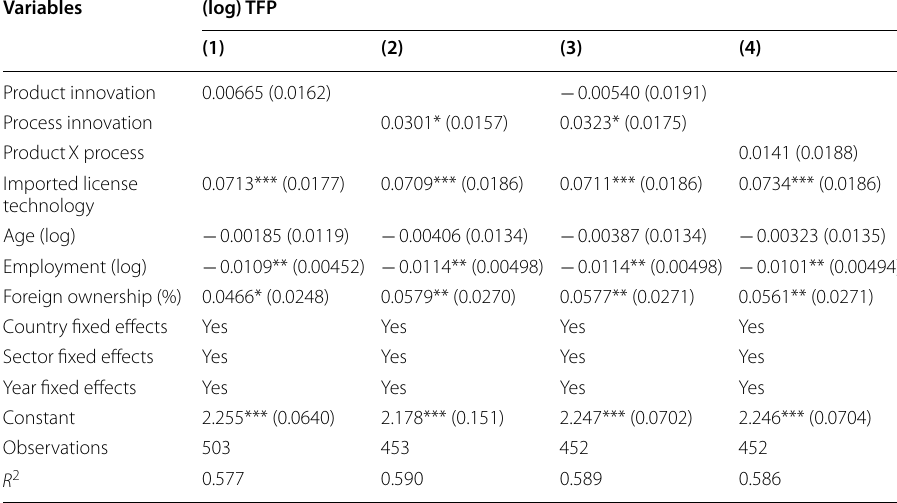
Table 5 Total factor productivity